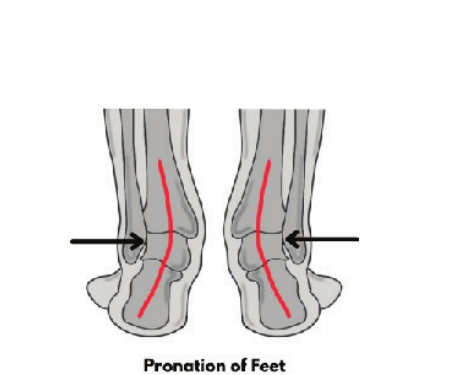
Figure-IV: Foot pronation as a result of a reduction of longitudinal and transverse arch height.